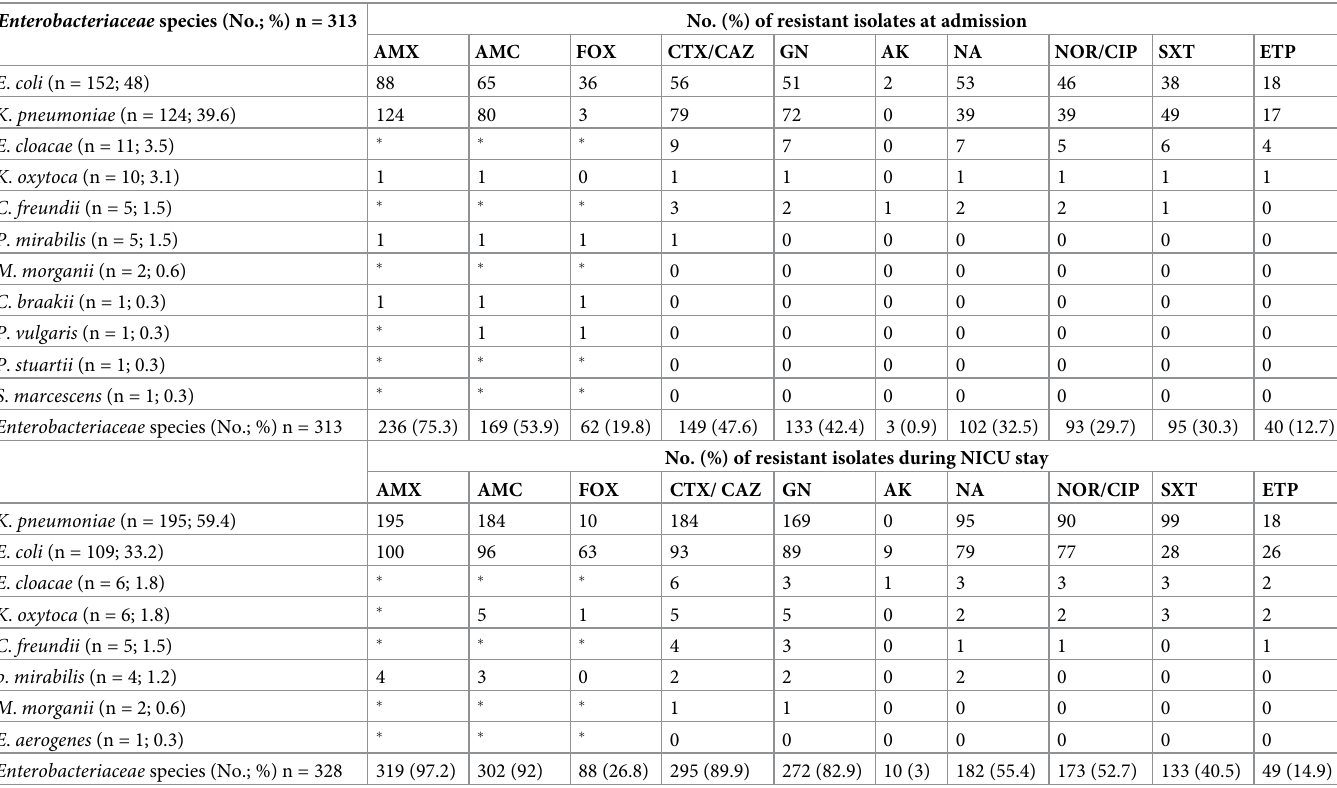
Table 4. Resistance profiles of the different Enterobacteriaceae isolated on admission and during hospitalization. Enterobacteriaceae species (No.; %) n =